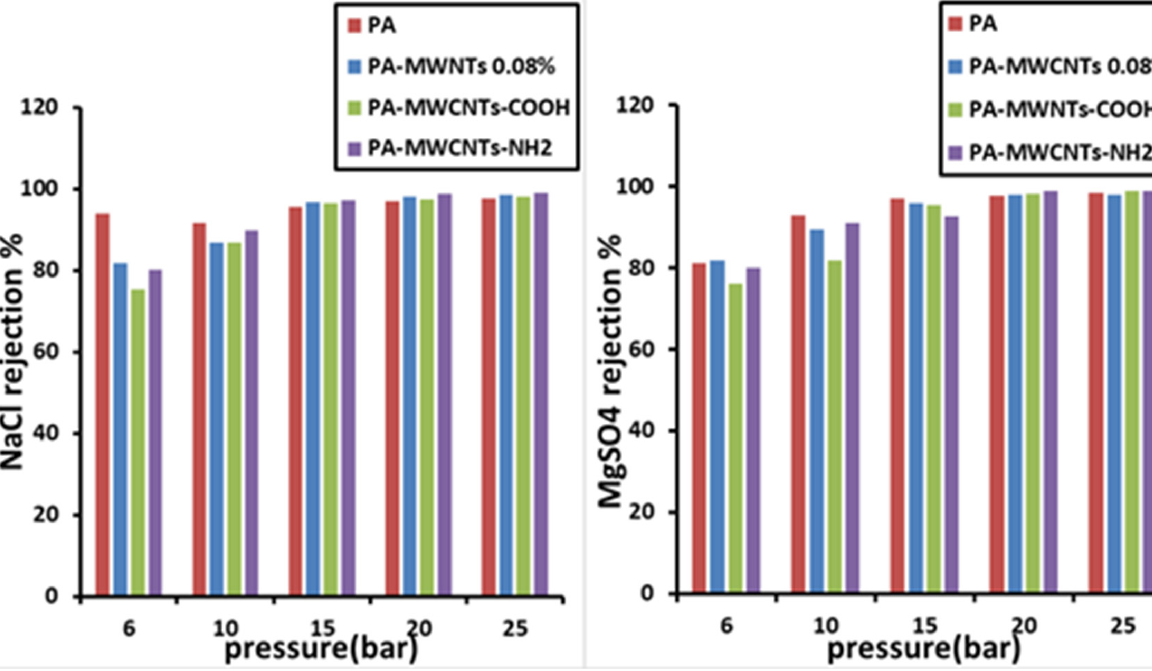
Figure 15. Salt rejection of PA and PA-MWCNTs, PA-MWCNTs-COOH, and PA-MWCNTs-NH 2